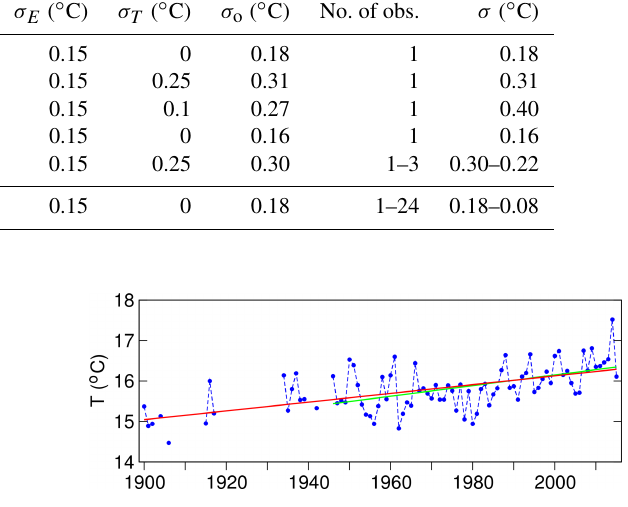
Figure 4. Data availability on a monthly basis for data set A (1899– 2008) and data set B (1986–2015).